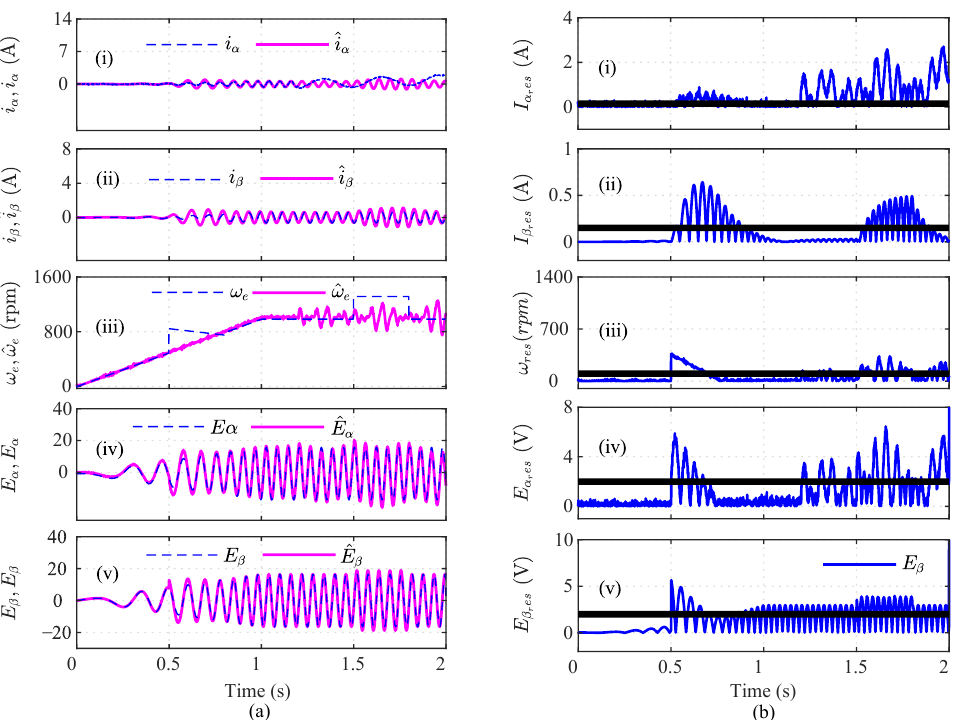
Figure 15. Illustration of current, speed, and voltage sensors’ observers during the incipient i α fault at t = 1.25 s and intermittent W ω fault scenario at t = 0.5 s and t = 1.50 s, respectively; ( a ) actual and estimated signal; ( b ) generated